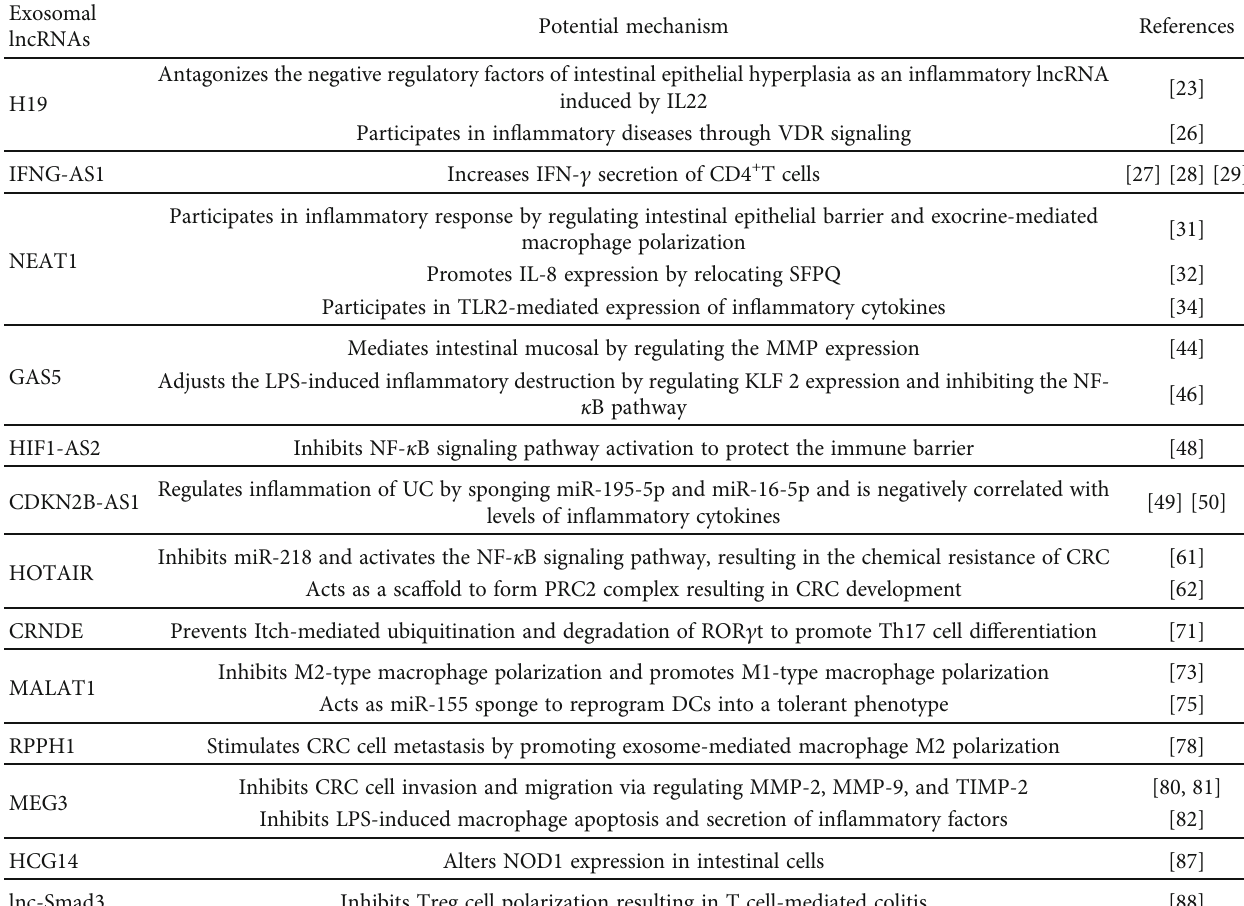
Table 1: The potential mechanism of exosomal lncRNAs in the intestinal mucosal immune